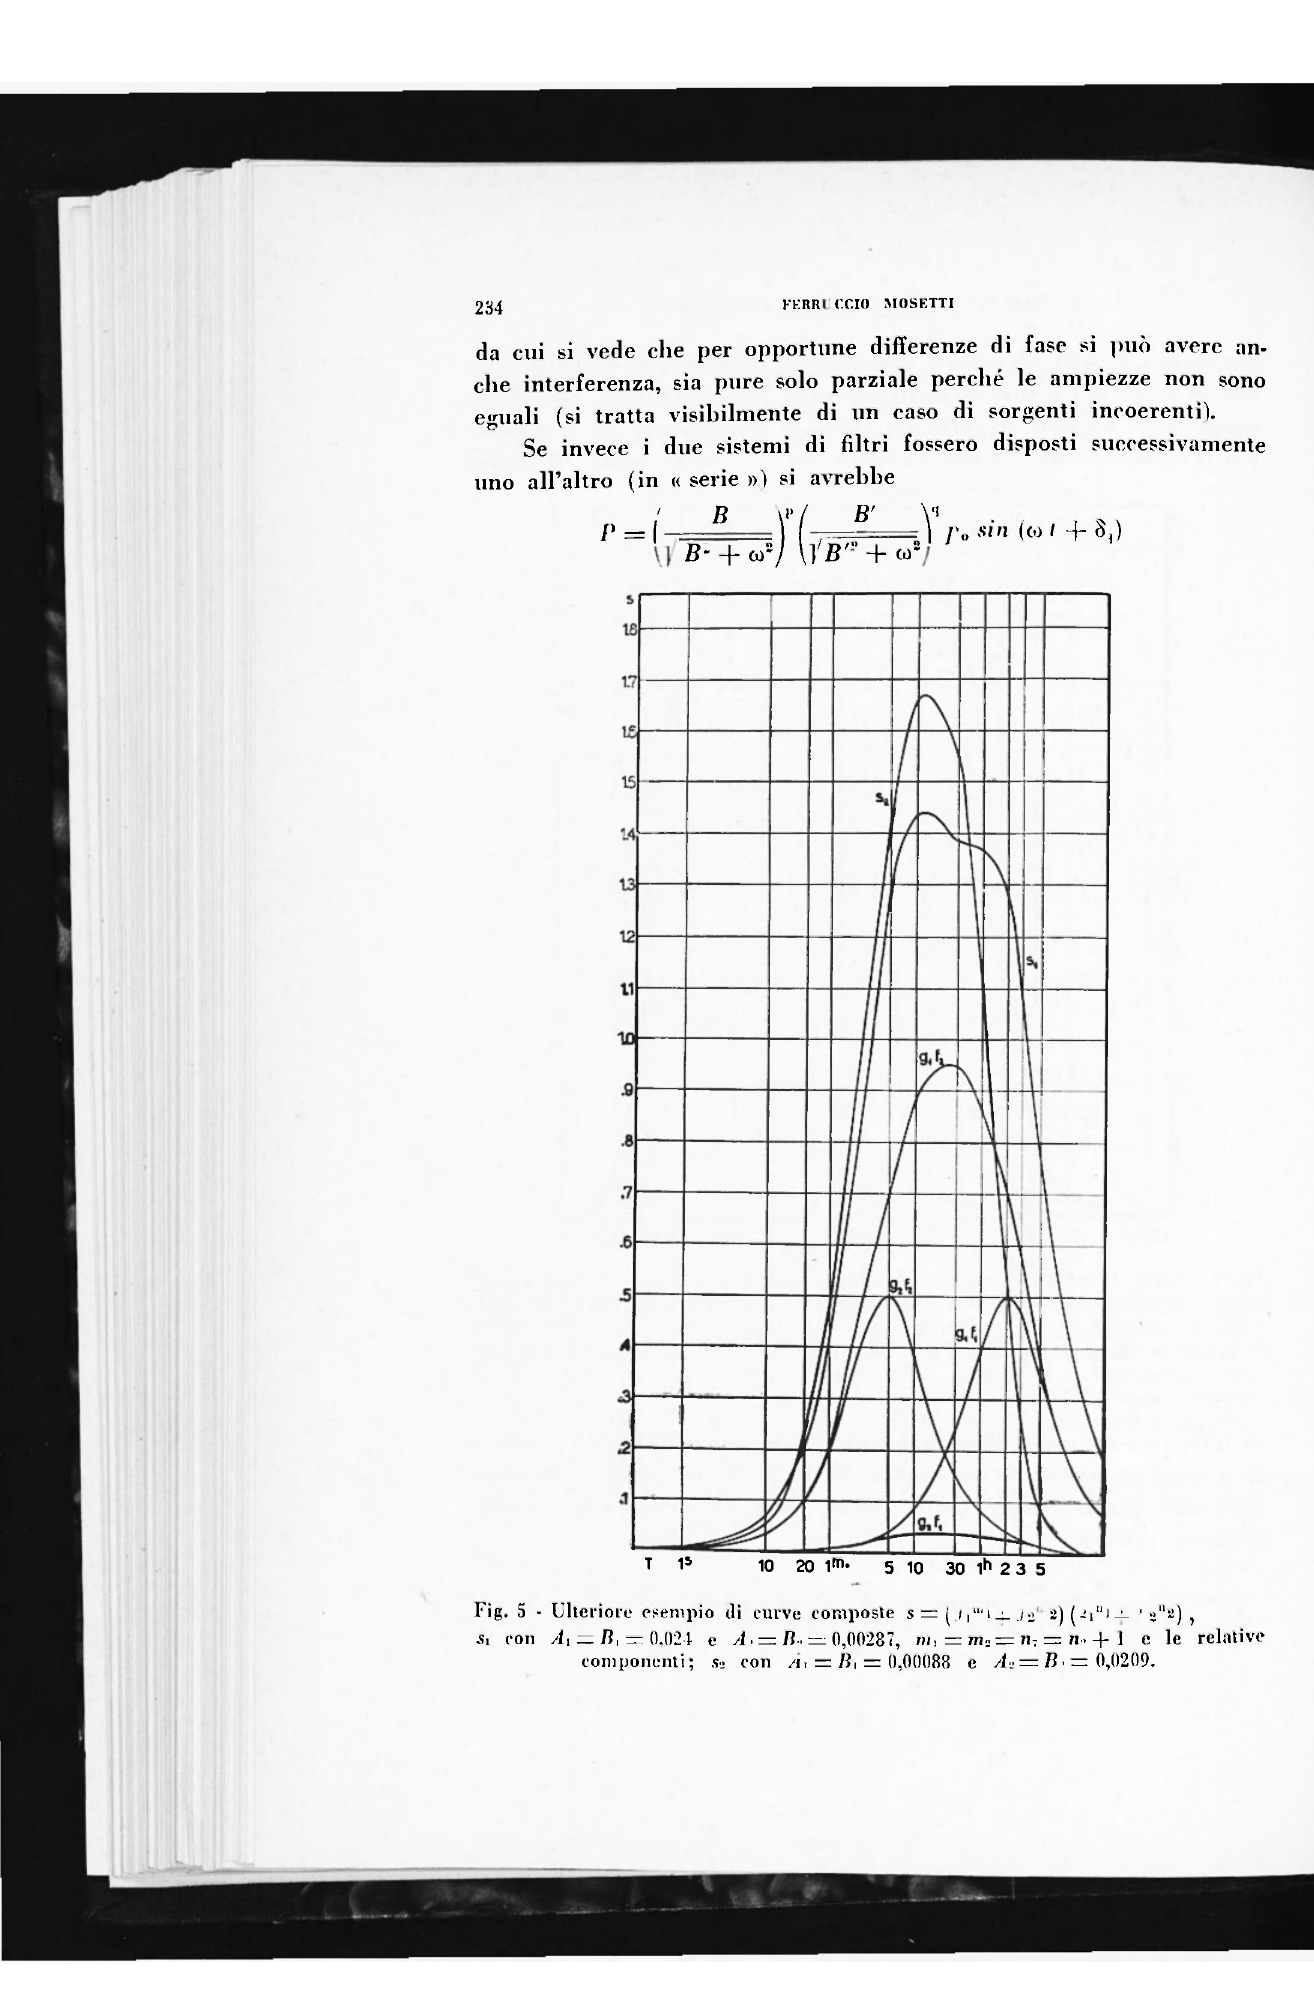
Fig. 5 - Ulteriore esempio di curve composte s = ( i,'" i _u j ^ a) (-'i"i ' s"2) , si con A, — B, = 0,024 e A- = B~ = 0,00287, m, = m 2 = n 7 = n» + 1 e le relative componenti; s = con = /?, = 0,00088 e A a = B< =i